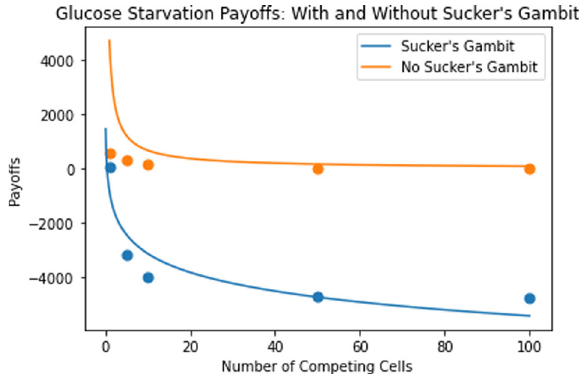
Fig. 9 Payoff from the glucose starvation treatment with and without a sucker ’ s gambit. Payoff is plotted as a function of the number of competing cells. Under the sucker's gambit strategy, we see a clear depression of the payoff curve per cell, with negative payoff values.